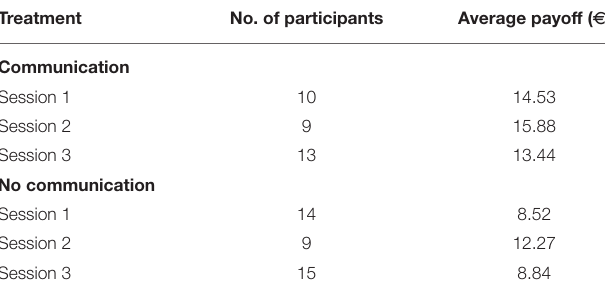
TABLE 1 | CPR treatments and demographic data. Treatment No. of